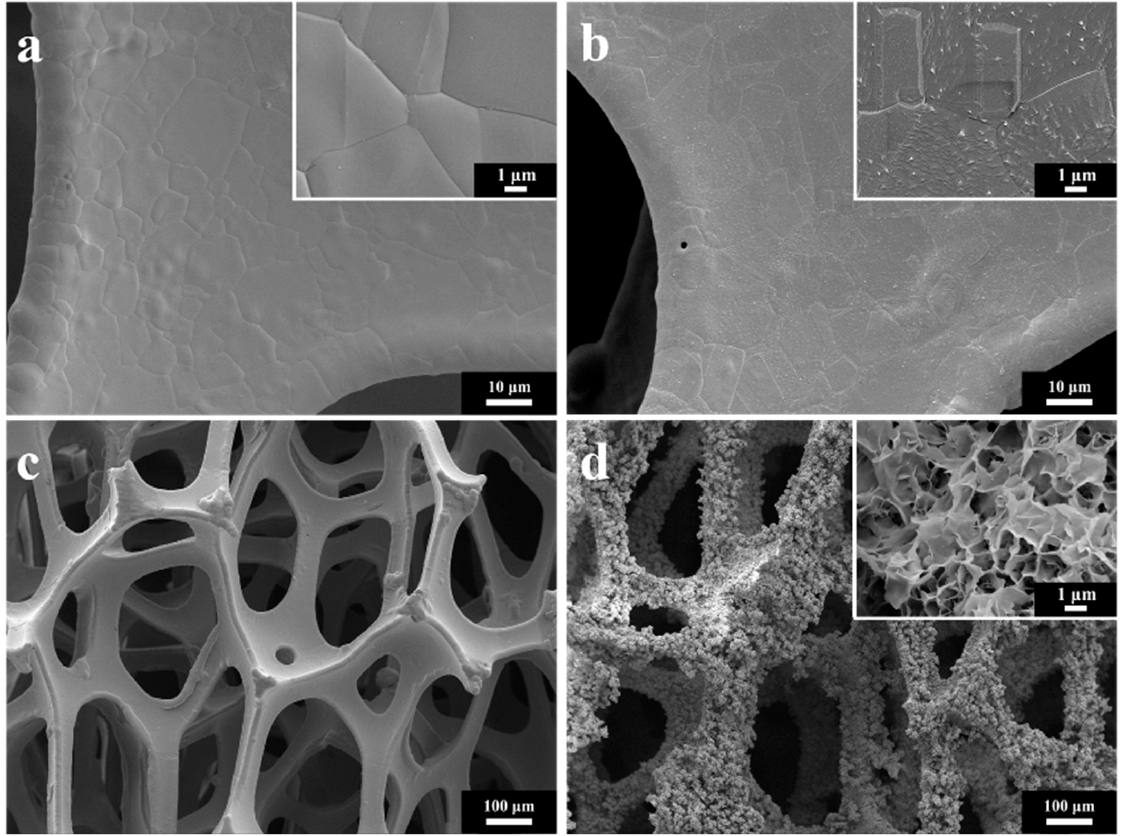
Figure 3. Low magnification and high magnification inset SEM images of ( a ) NF before pretreatment, ( b ) NF after pretreatment, ( c ) NF before hydrothermal treatment and ( d ) Low magnification and high magnification inset SEM images of NiCoMo 2 -LDH/NF after hydrothermal treatment. The structure of the NiCoMo 2 -LDH/NF nanosheets was further confirmed by the TEM analysis (Figure 5a). As shown in Figure 5a, the NiCoMo 2 -LDH/NF nanosheets can be observed clearly. The high-resolution TEM (HRTEM) image (Figure 5b) shows various kinds of lattice fringes with distances of 0.216, 0.244, 0.262 and 0.267 nm corresponding to the (222), (400) and (222) planes of CoMoO 4 and (100) planes of Ni(OH) 2 , respectively. As shown in Figure 5c, the selected area electron diffraction (SAED) pattern shows (100) and (110) planes for Ni(OH) 2 , and (222) planes for CoMoO 4, indexed according to the reported X-ray diffraction (XRD)